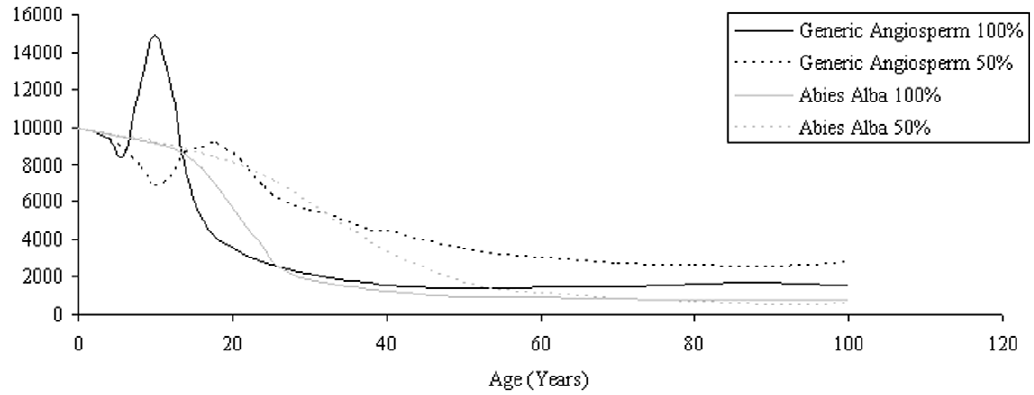
Figure 9. Thinning with respect to age for AbiesAlba and Generic Angiosperm. Planting densities of 10000 ha 2 1 . Light intensity variations shown in